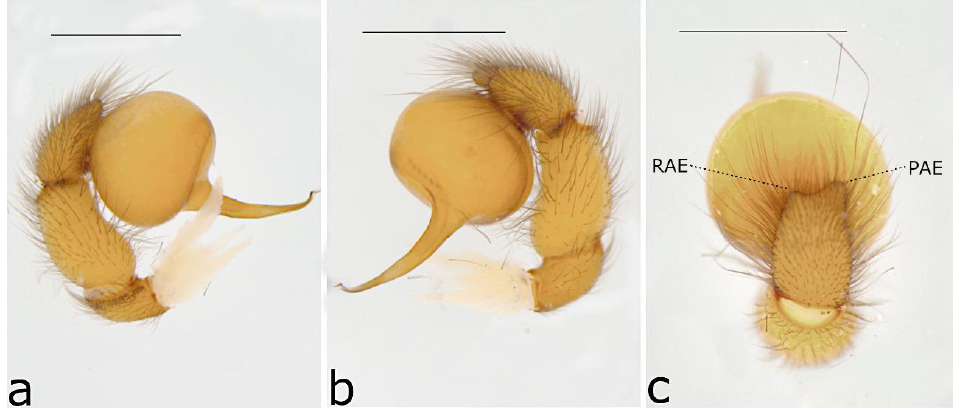
Figure 63. Ariadna una sp. nov. ♂ holotype (SAMA NN10578) from near Illintjitja (SA): ( a ) left pedi- palp, prolateral view; ( b ) same, retrolateral view; ( c ) same, cymbium. Scale bar = 1 mm.